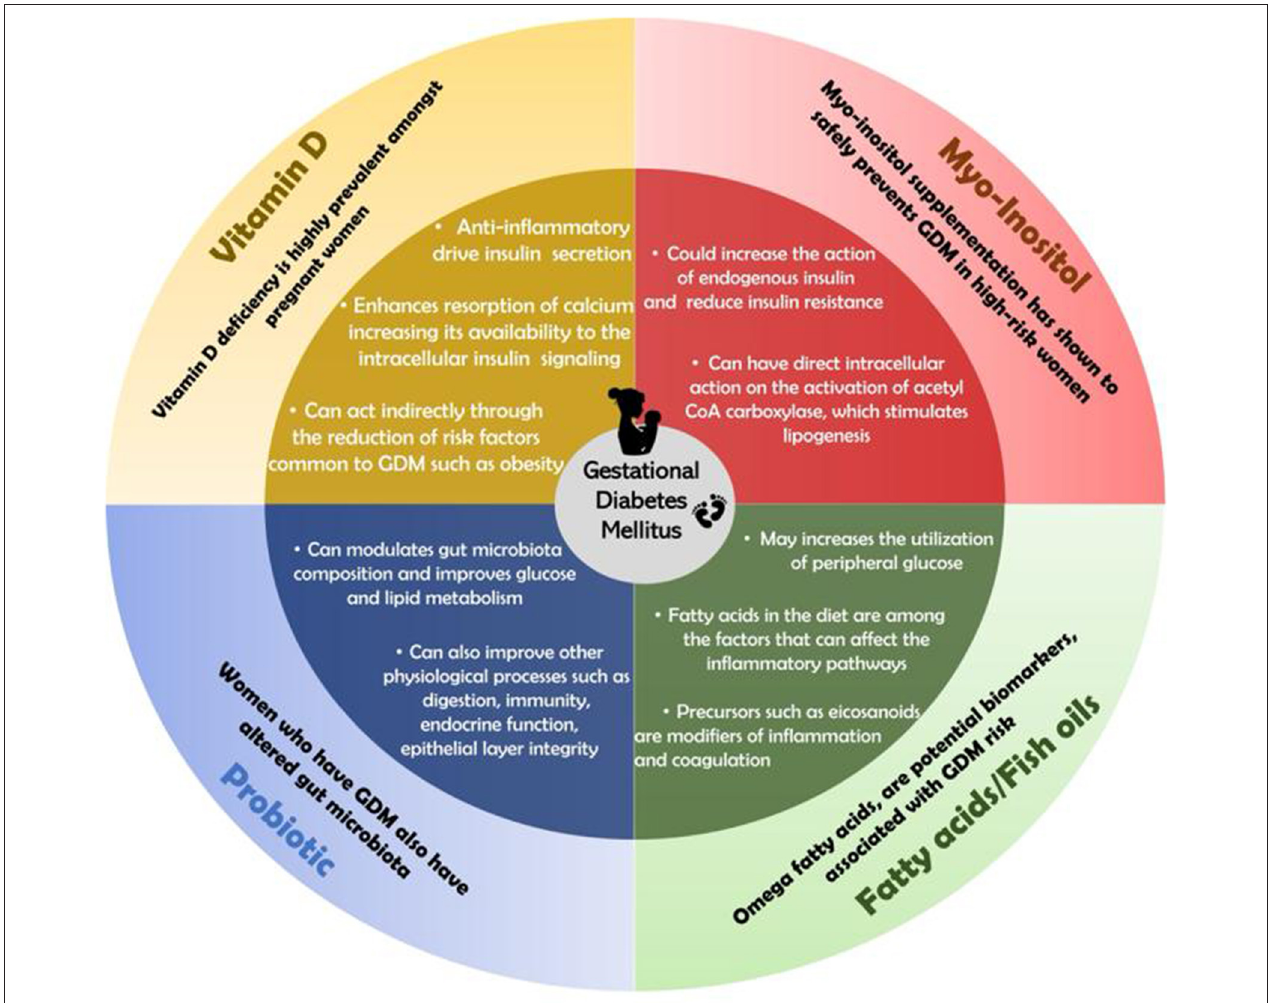
FIGURE 1 | The effect of nutritional supplementation on glucose metabolism during